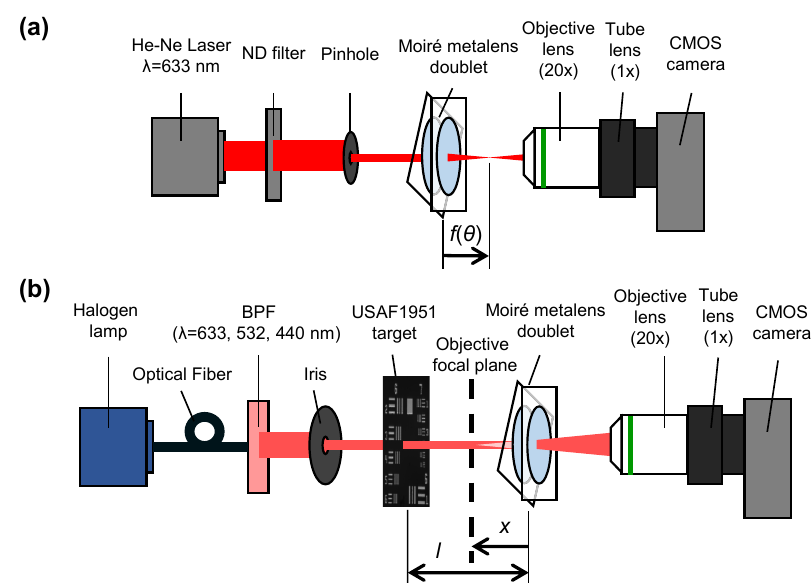
Figure 3: Experimental setup for the perfor- manceevaluationofmetalens:(a)forpositive mutual rotation angles and (b) for negative mutual rotation angles. by the misalignment between the two metasurfaces. The misalignment was measured to be 2 μ m (not